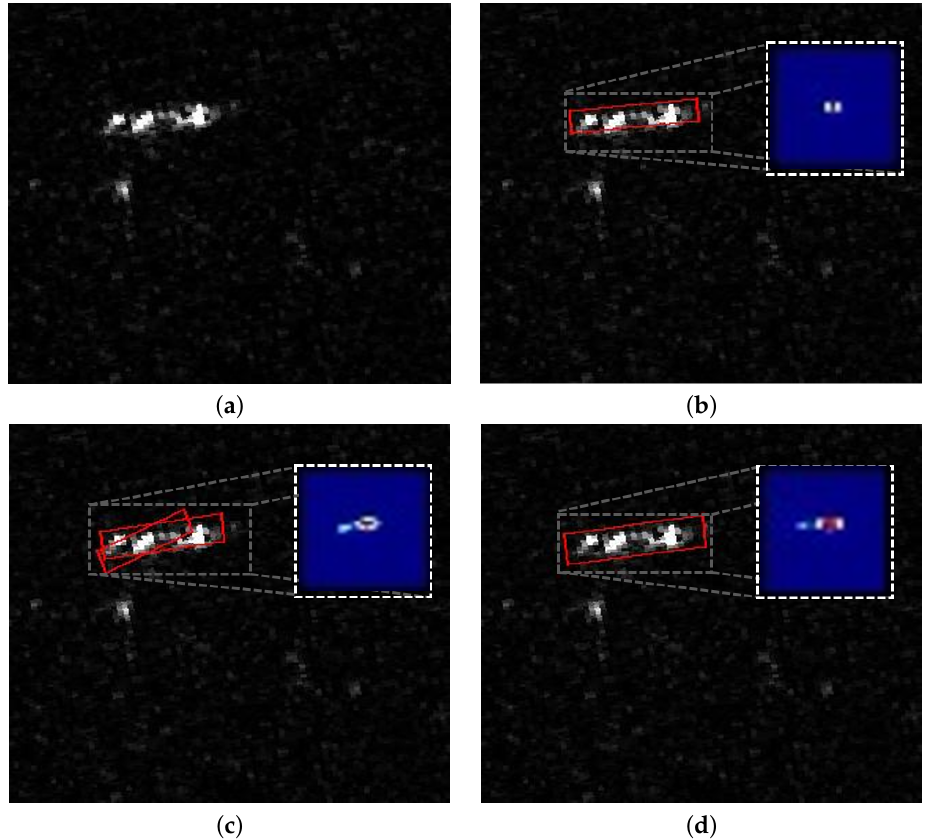
Figure 11. The detection results of the model based on different sample balancing strategies and cor- responding heatmaps: ( a ) original picture; ( b ) circular Gaussian; ( c ) elliptical Gaussian; ( d ) multiscale elliptical Gaussian.